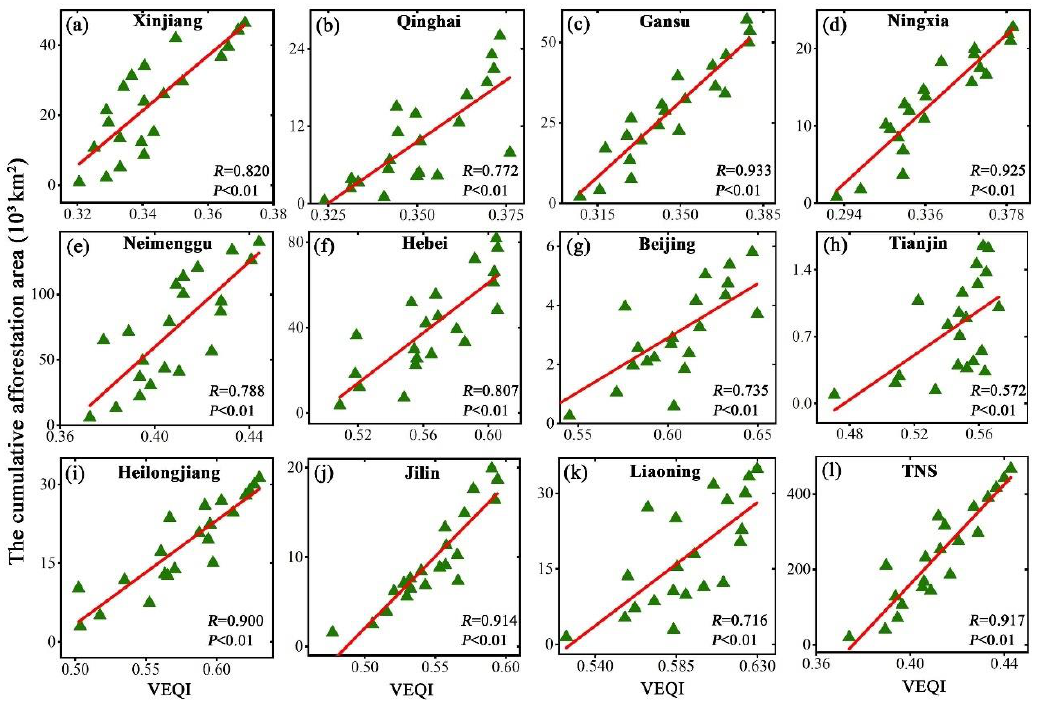
Figure 15. The relationships between the cumulative planted area and VEQI ( l ) in the TNS and each province ( a – k